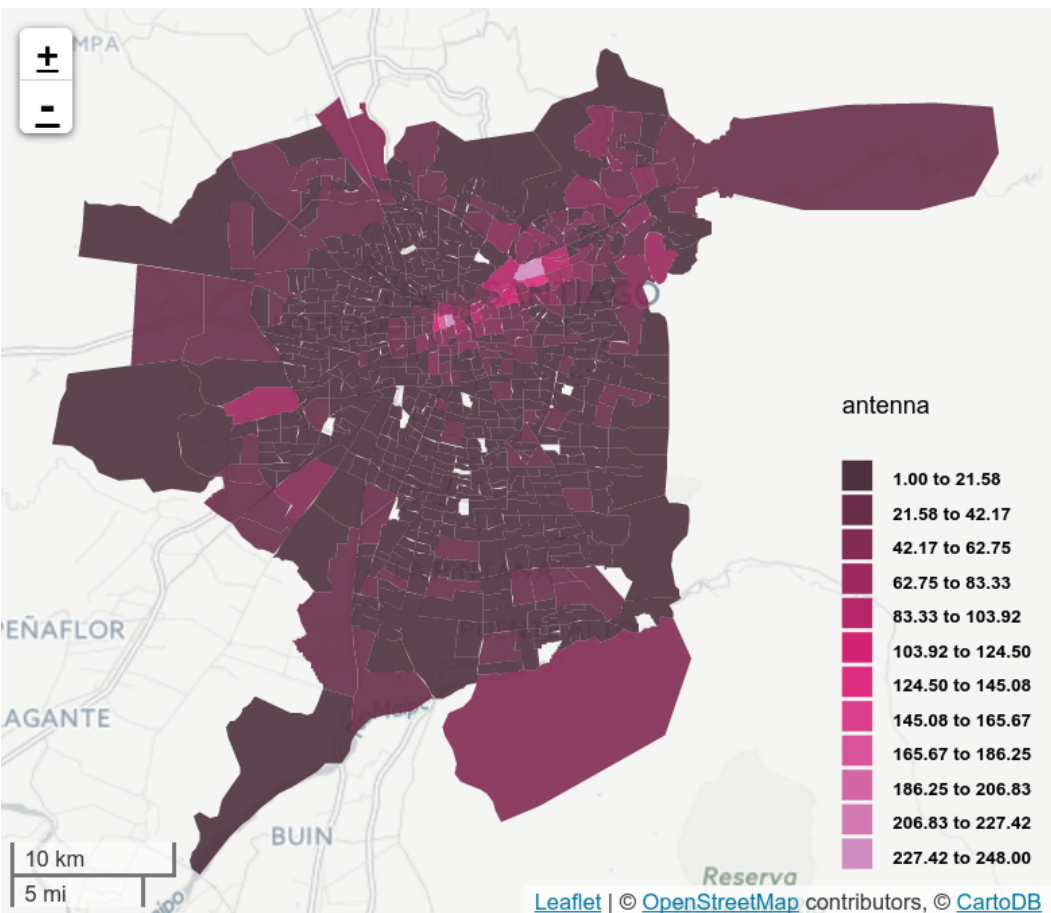
Figure 7. The 752 zones from the OD Survey zoning. Colors indicate antenna density in each zone according to geographical positions obtained using the AVP